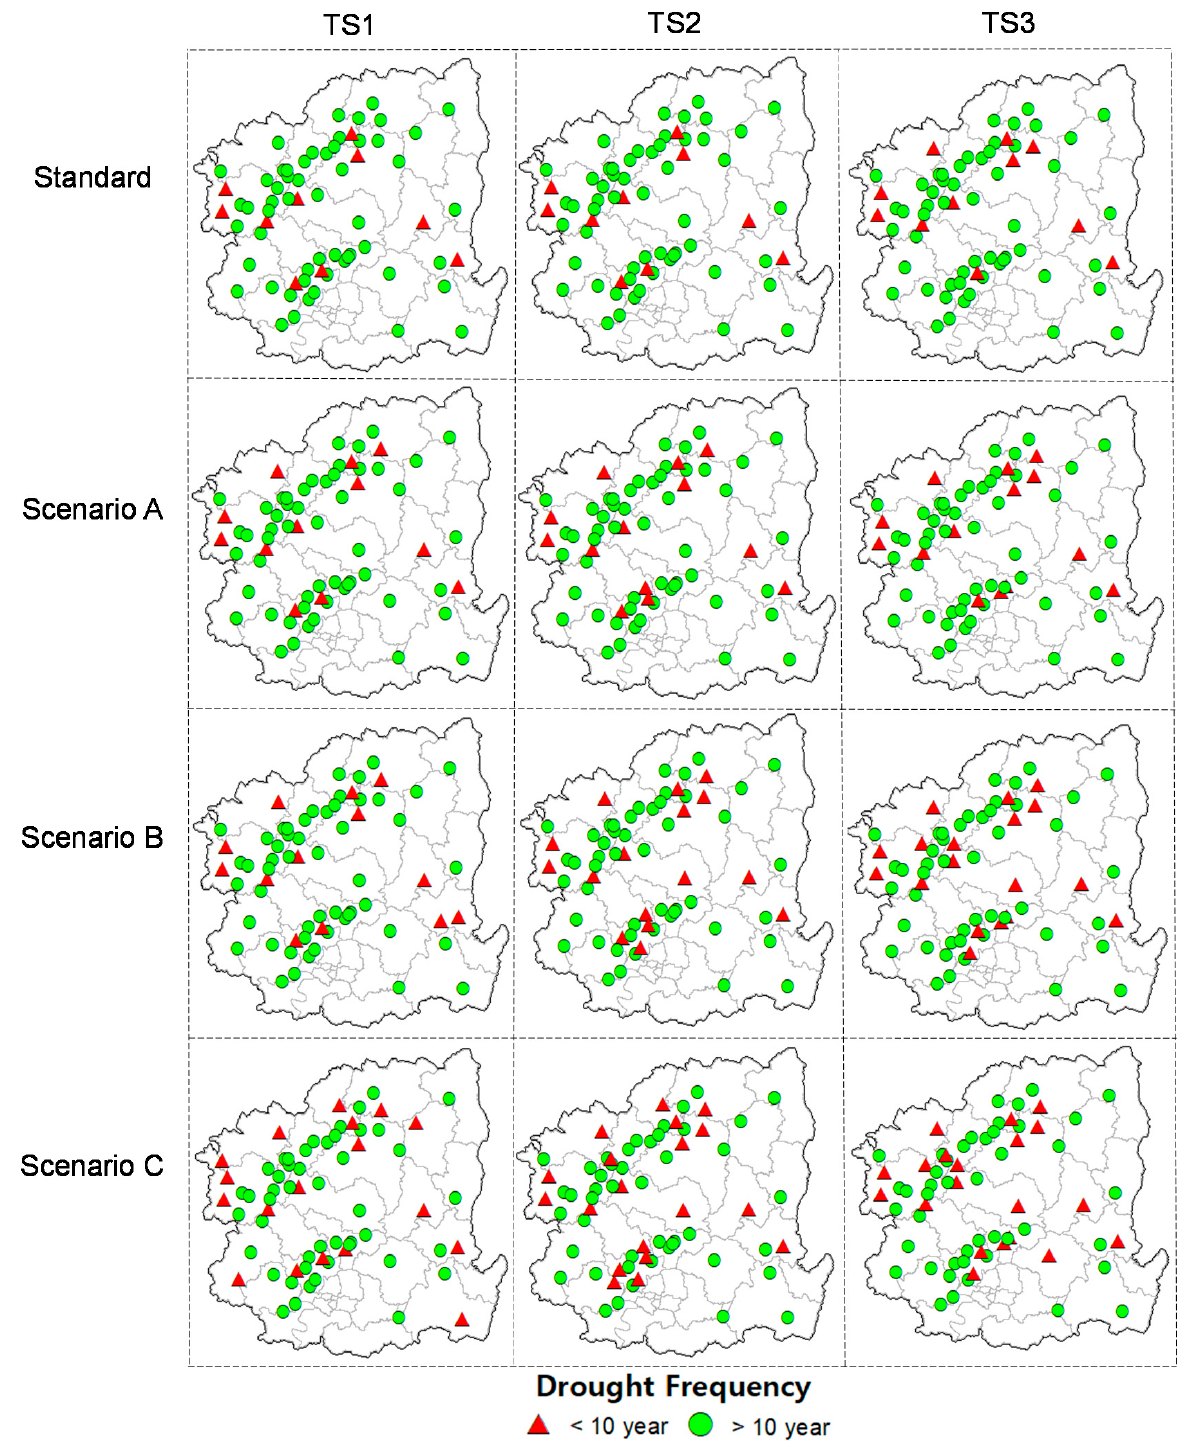
Figure 6. Water supply reliability (WSR) of selected reservoirs during the TS1 (1973–1987), TS2 (1988–2002) and TS3 (2003–2017) depending on the transplanting scenarios. Description of the transplanting scenarios is provided in Table 2.